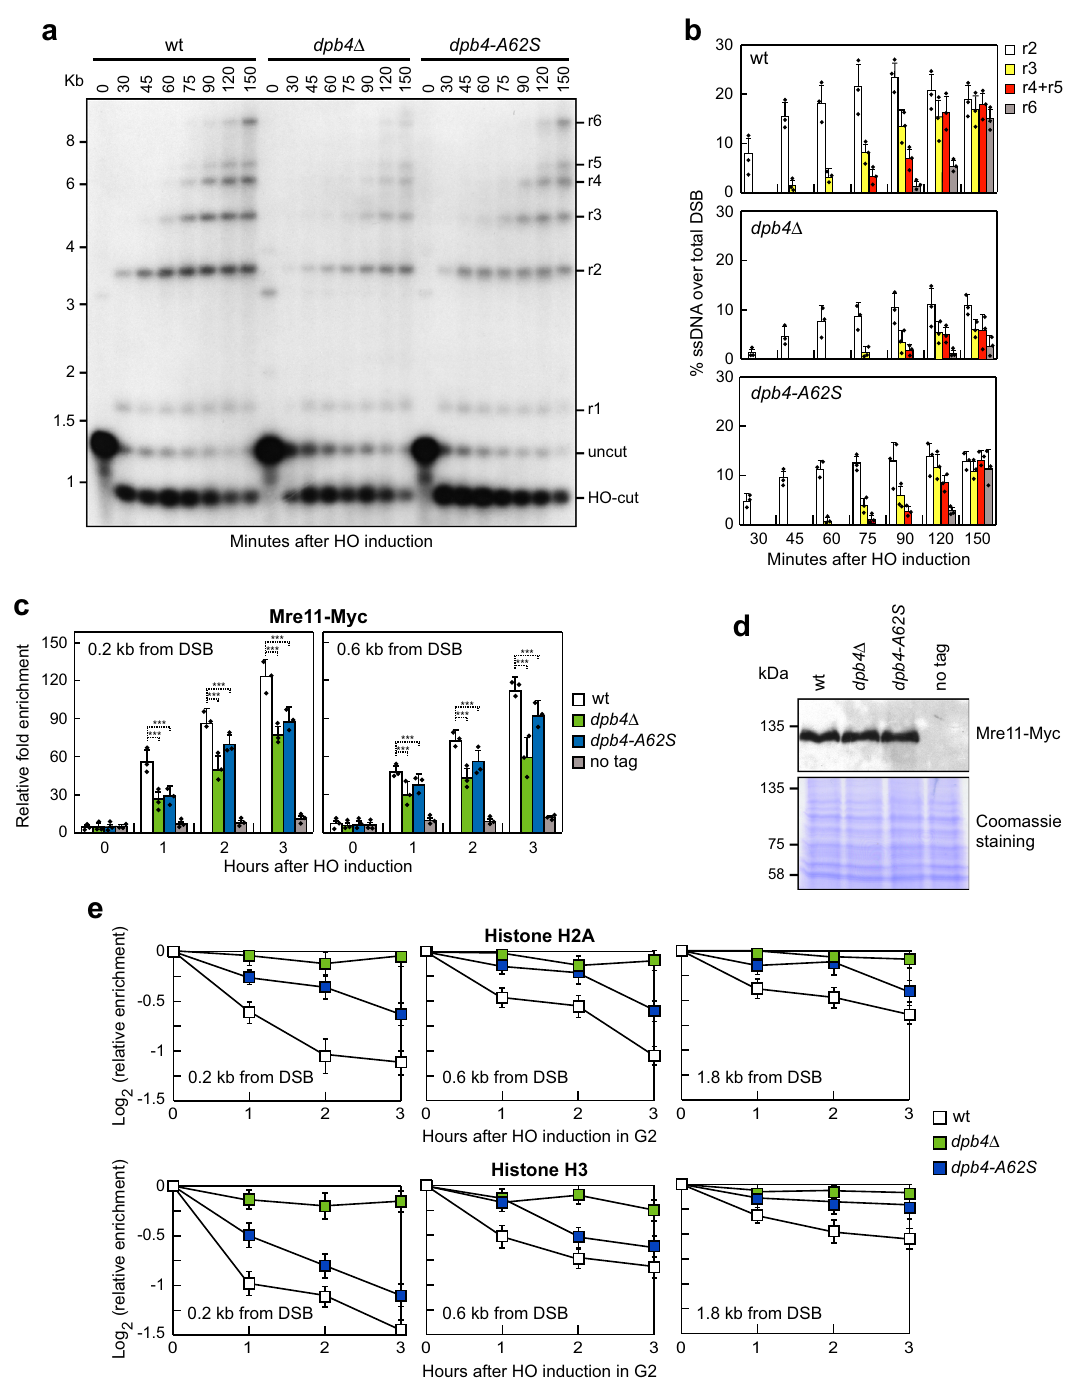
Fig. 2 dpb4 Δ and dpb4-A62S alleles reduce DSB resection, MRX association at DSBs, and histone removal from the DSB ends. a DSB resection. YEPR exponentially growing cell cultures of JKM139 derivative strains, carrying the HO cut site at the MAT locus, were transferred to YEPRG at time zero. Ssp I- digested genomic DNA was hybridized with a single-stranded MAT probe that anneals with the unresected strand. 5 ′ – 3 ′ resection produces Ssp I fragments (r1 through r6) detected by the probe. b Densitometric analysis of the resection products. The mean values of three independent experiments as in a are represented with error bars denoting standard deviation (s.d.). c Exponentially growing YEPR cell cultures of JKM139 derivative strains were transferred to YEPRG to induce HO. Relative fold enrichment of Mre11-Myc at the HO-induced DSB was evaluated after ChIP with anti-Myc antibody and qPCR. The mean values of three independent experiments are represented with error bars denoting s.d. *** p < 0.005 (unpaired two-tailed Student ’ s t -test). d Western blot with anti-Myc antibodies of protein extracts from exponentially growing cells. This experiment was performed independently three times with similar results. e HO expression was induced at time zero by galactose addition to G2-arrested cells that were kept arrested in G2 by nocodazole throughout the experiment. Relative fold enrichment of H2A or H3 at the HO-induced DSB was evaluated after ChIP with anti-H2A or anti-H3 antibody and qPCR analysis. The mean values of three independent experiments are represented with error bars denoting s.d. See source data fi le for statistical